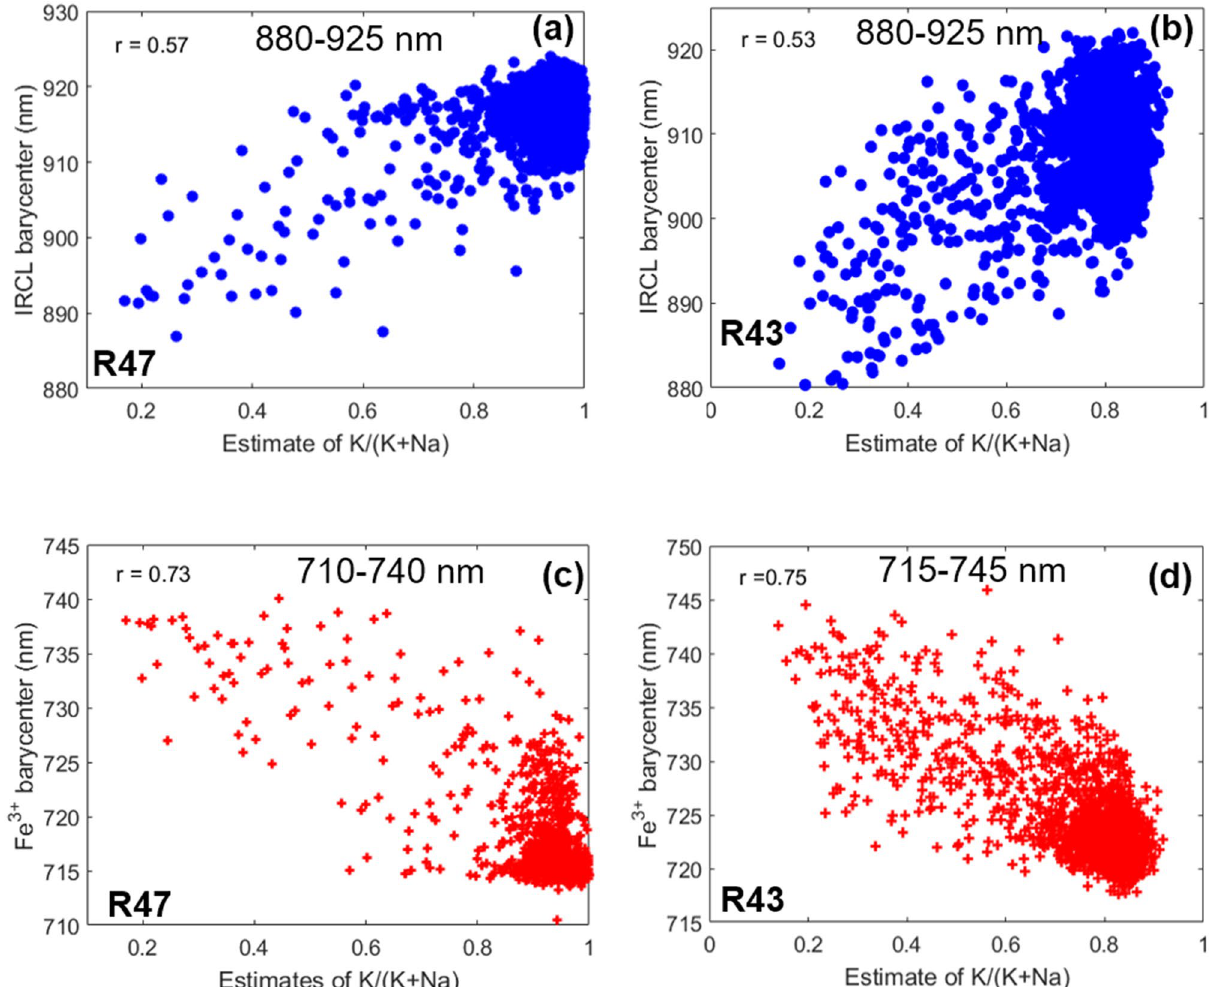
Figure 4. Correlation between the IRCL emission barycenter and relative K concentration in ( a ) sample R47, ( b ) sample R43. Correlation between the Fe 3+ emission barycenter and relative K concentration in ( c ) sample R47, ( d ) sample R43. Each data point was obtained by the binning of two nearby pixels. These images were generated using Matlab (Version: R2016, Url: https ://www.mathw orks.com/produ cts/matla